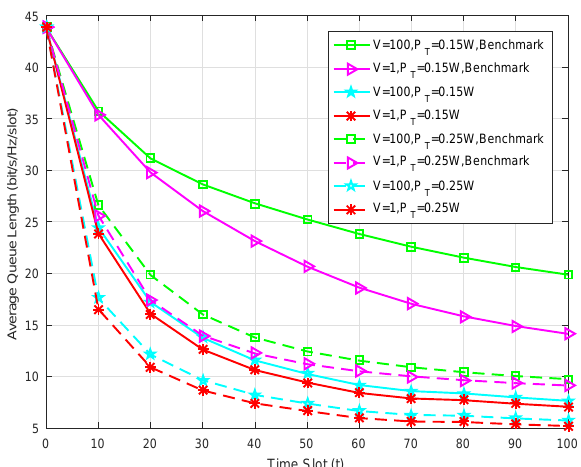
Figure 3. Average queue length at the observed time slot for K = 6 and R T = 16.